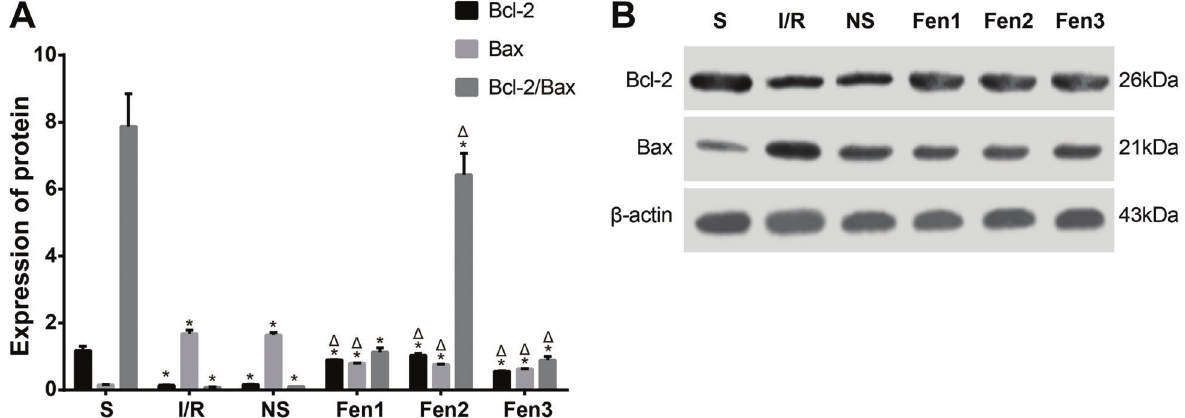
Figure 6. Bcl-2 and Bax protein expressions, and Bcl-2/Bax ratio in the sham operation (S) group, ischemia-reperfusion (I/R) group, normal saline (NS) group, and fentanyl (Fen)1 group (2 m g/kg), Fen2 group (4 m g/kg), and Fen3 group (6 m g/kg) ( A , bar chart; B , electropherogram of western blot). Bcl-2: B-cell lymphoma 2; *P o 0.05 compared to the S group; D P o 0.05 compared to the I/R group (one-way ANOVA).